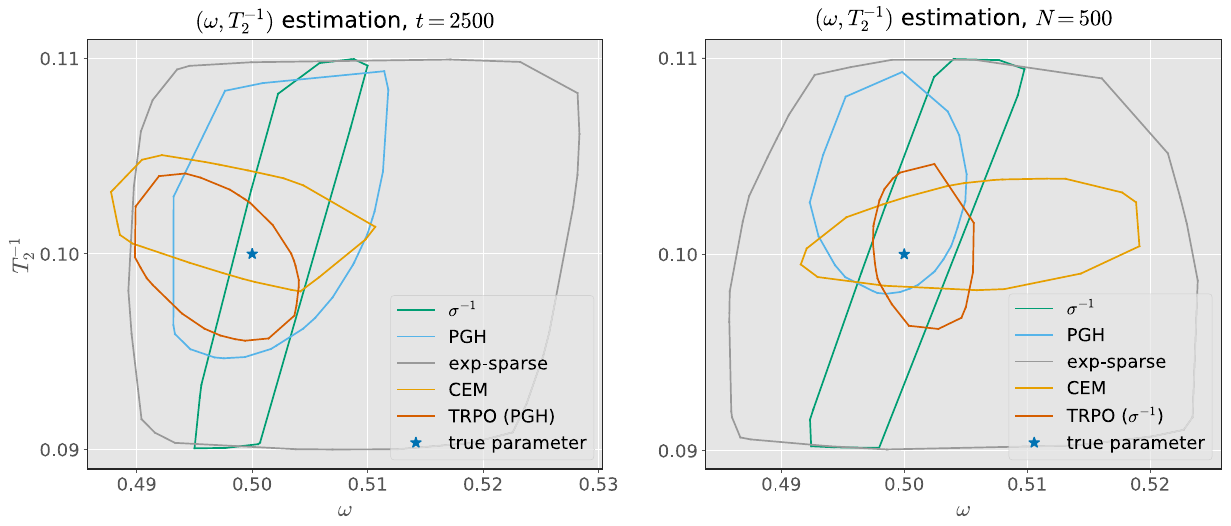
) . The credible regions correspond to the uncer- 2 ∈ ( 0.09, 0.11 ) 2